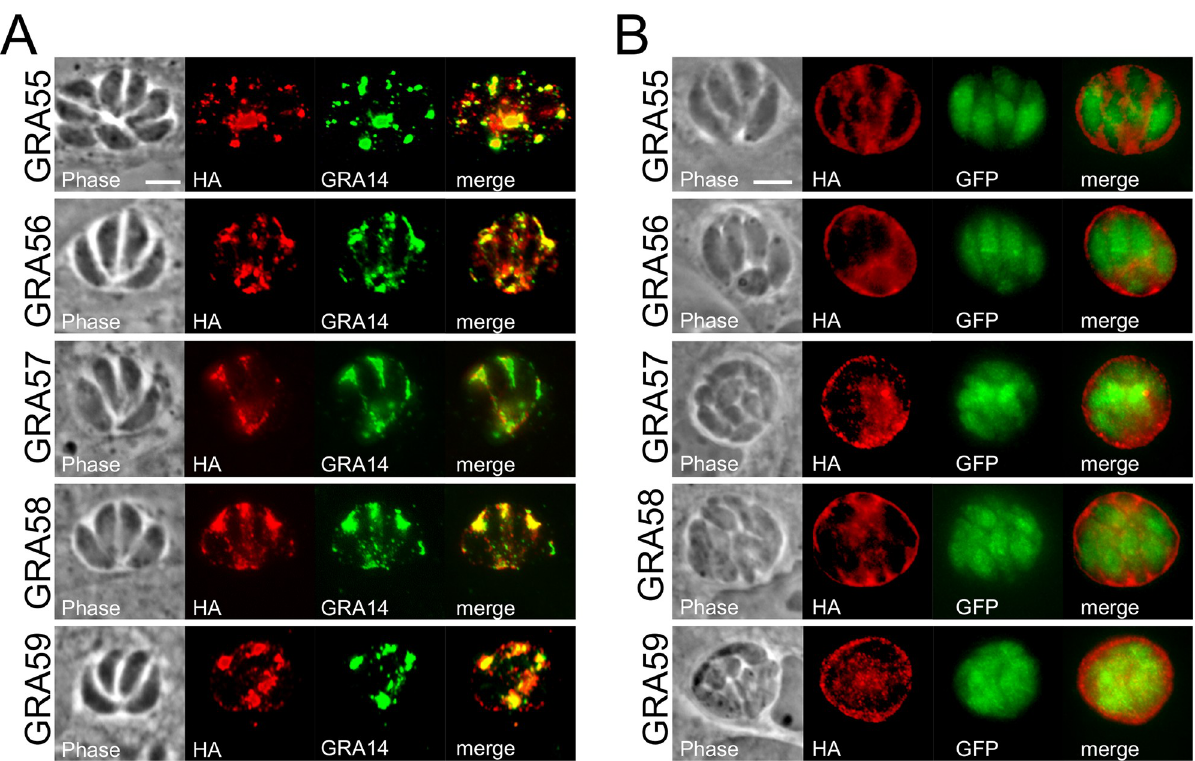
Fig 2. Identification of novel dense granule proteins, GRA55-GRA59 by MAG1-BioID. (A) IFA of tachyzoites with rabbit anti-HA antibodies shows strong staining of the parasitophorous vacuole for each novel GRA that colocalizes with GRA14, demonstrating that these are novel dense granule proteins. Gene numbers and novel designations are as follows: GRA55 (TgME49_309760), GRA56 (TgME49_309930), GRA57 (TgME49_217680), GRA58 (TgME49_268790), and GRA59 (TgME49_313440). Scale bar: 5 μ m. (B) IFA of bradyzoites with mouse anti-HA antibodies shows staining of each GRA at the cyst periphery and vacuolar space. Transgenic parasites expressed GFP, driven by LDH 2 promoter, upon successful bradyzoite conversion. Images were taken three days after growth under alkaline-stressed conditions. Scale bar: 5 μ m.